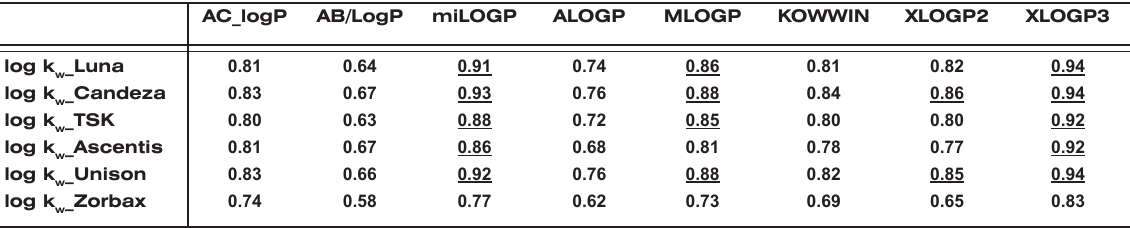
AC_logP AB/LogP miLOGP ALOGP MLOGP KOWWIN XLOGP2 XLOGP3